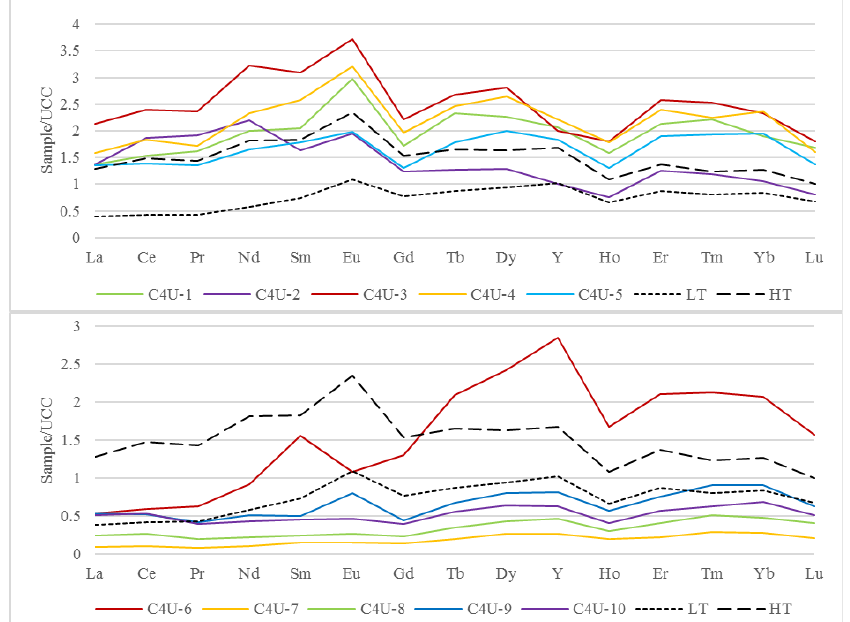
Figure 11. Standardized distribution patterns of rare earth elements of the C4-Upper coal seam. Note: LT and HT mean low-Ti and high-Ti basalts of the Emeishan Large Igneous Province, respectively, and these data are from Xiao et al. [42].